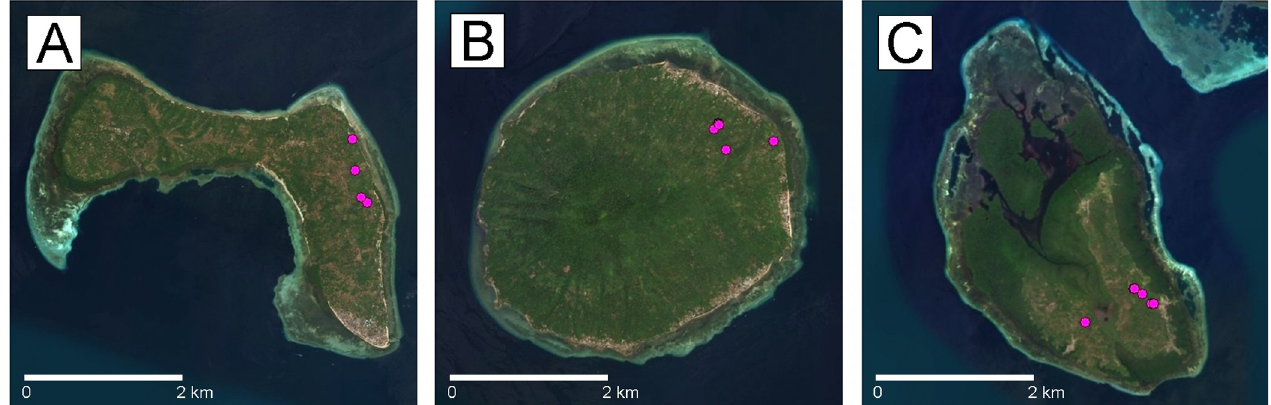
Fig 3. The approximate locations of tarsier sleeping sites on the study sites. A) Bunaken, B) Manadotua, and C) Mantehage.